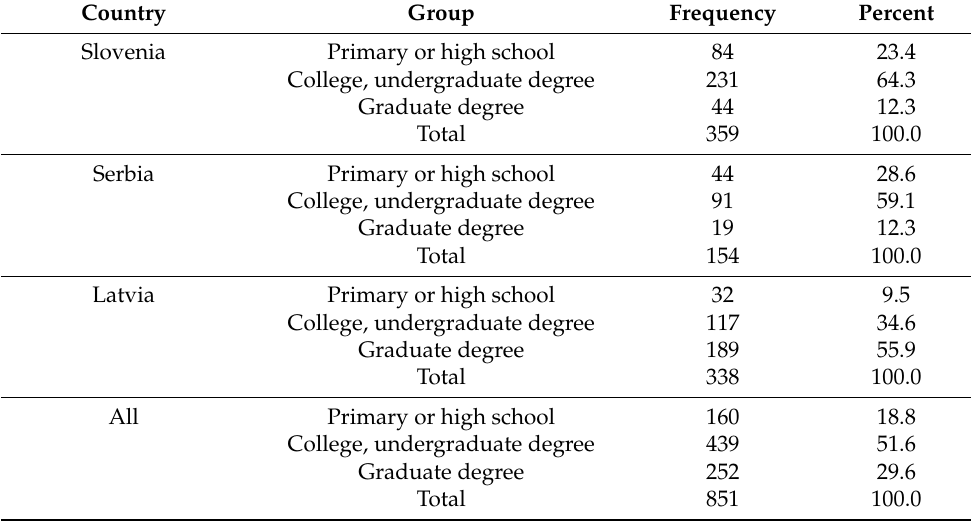
Table A11. Achieved educational